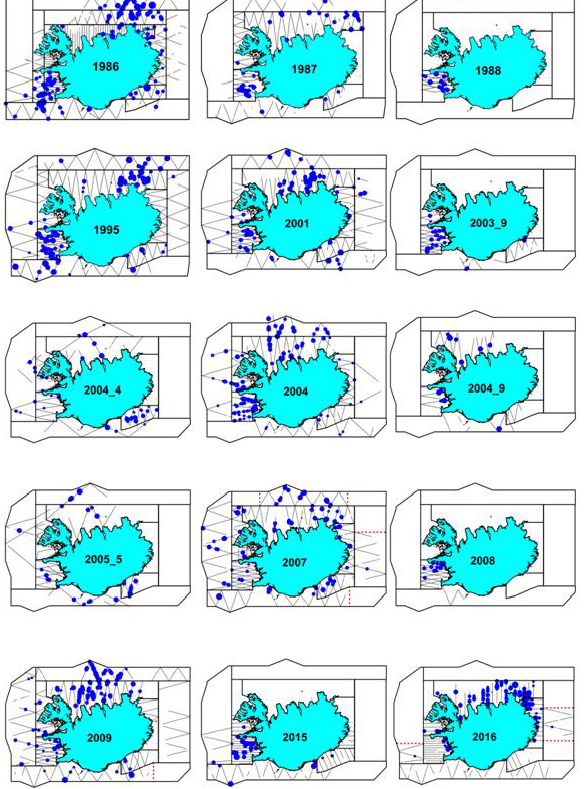
Figure 6. Realized survey effort and sightings of white-beaked dolphins by survey. Sightings of unidentified dolphins are included in 2003, 2004 and 2005 but not in other years. Survey month is appended to year (numerical) if not June or July. Symbol sized varies with group size from 1 to 30. Post-stratification borders are shown as red dotted lines.